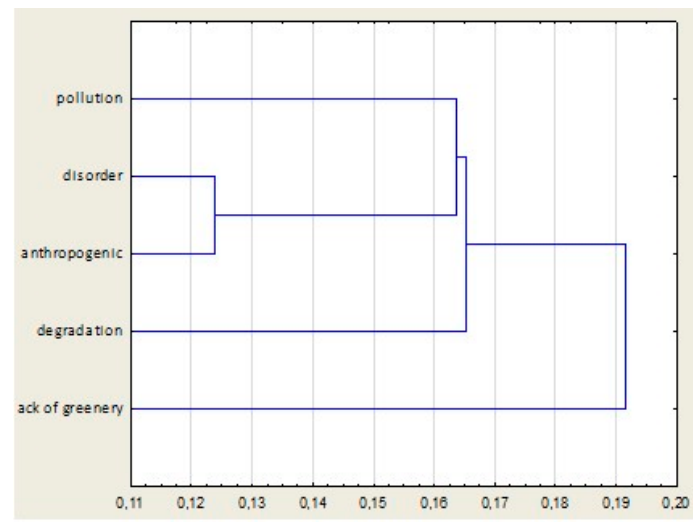
Figure 9. Grouping of the assessment indicators of the degraded landscape (EnvEng and CivEng students combined, n = 244).